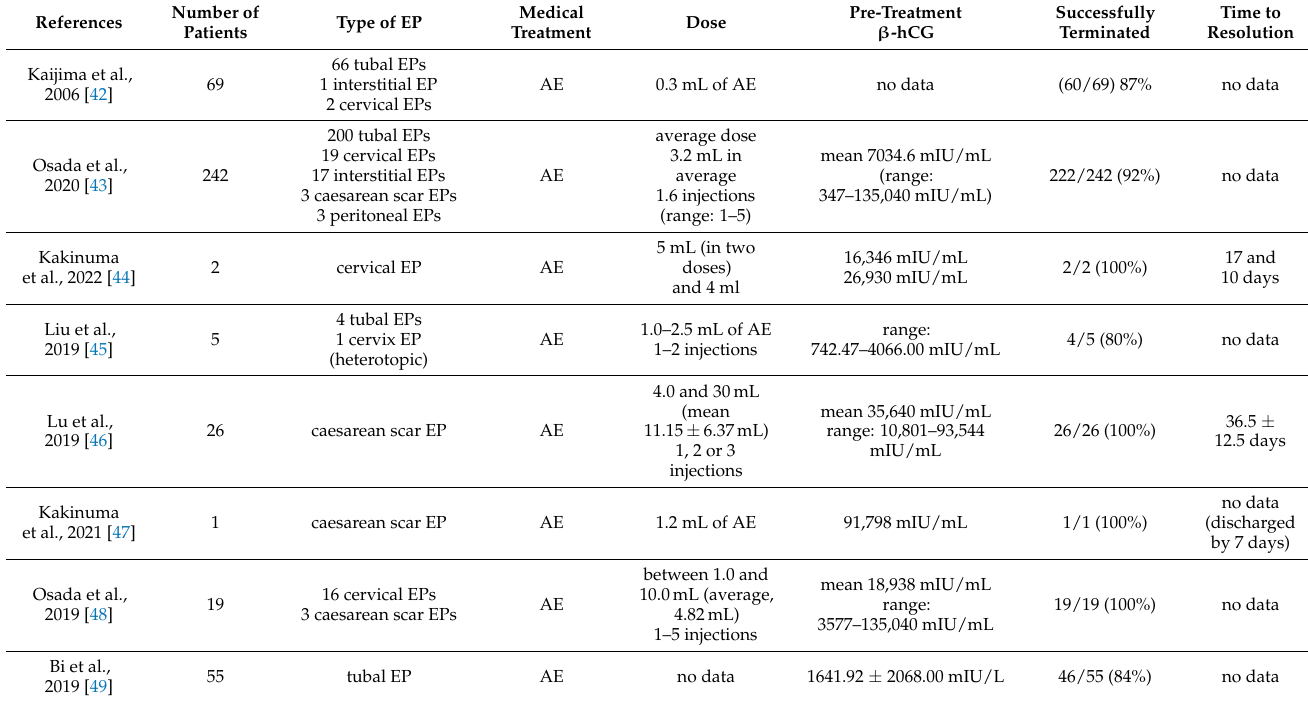
Table 2. Review of the literature describing absolute ethanol treatment in